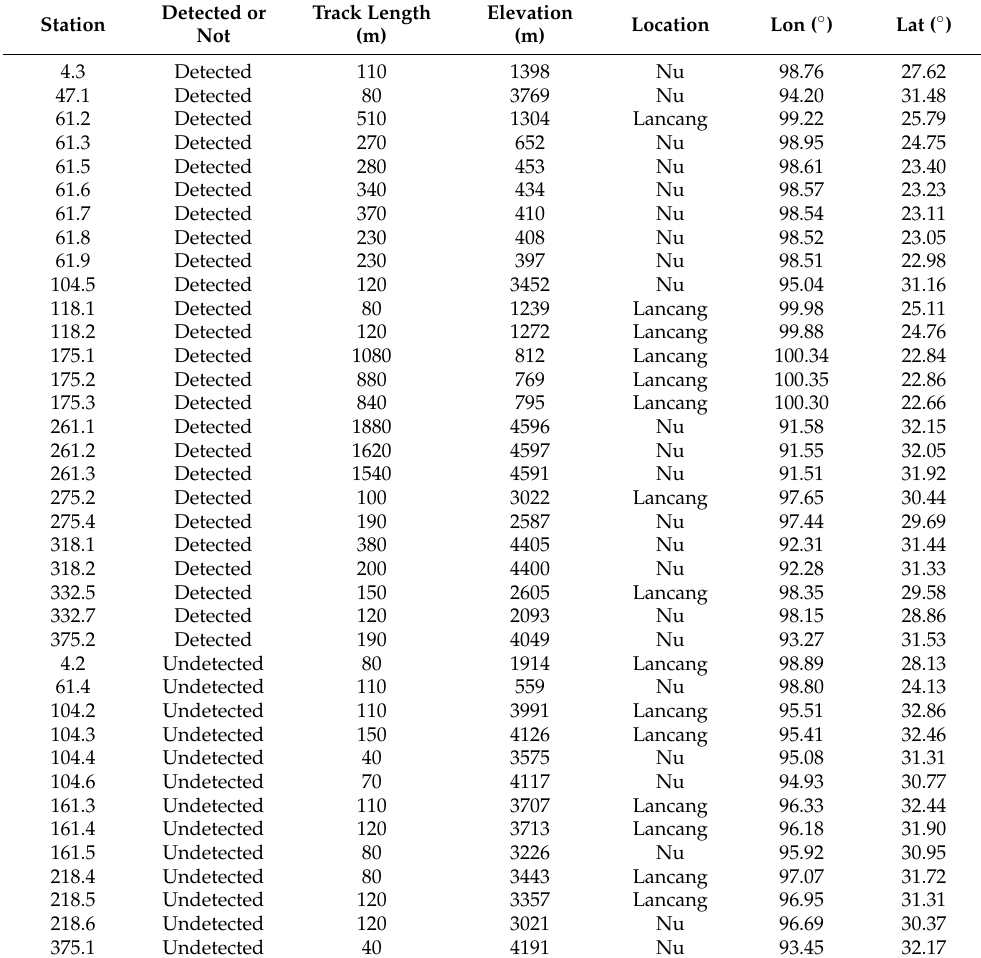
Table A2. Information on virtual stations in S3A for this study, including station number, track length (estimated from Google Earth), elevation (estimated from ALOS), and